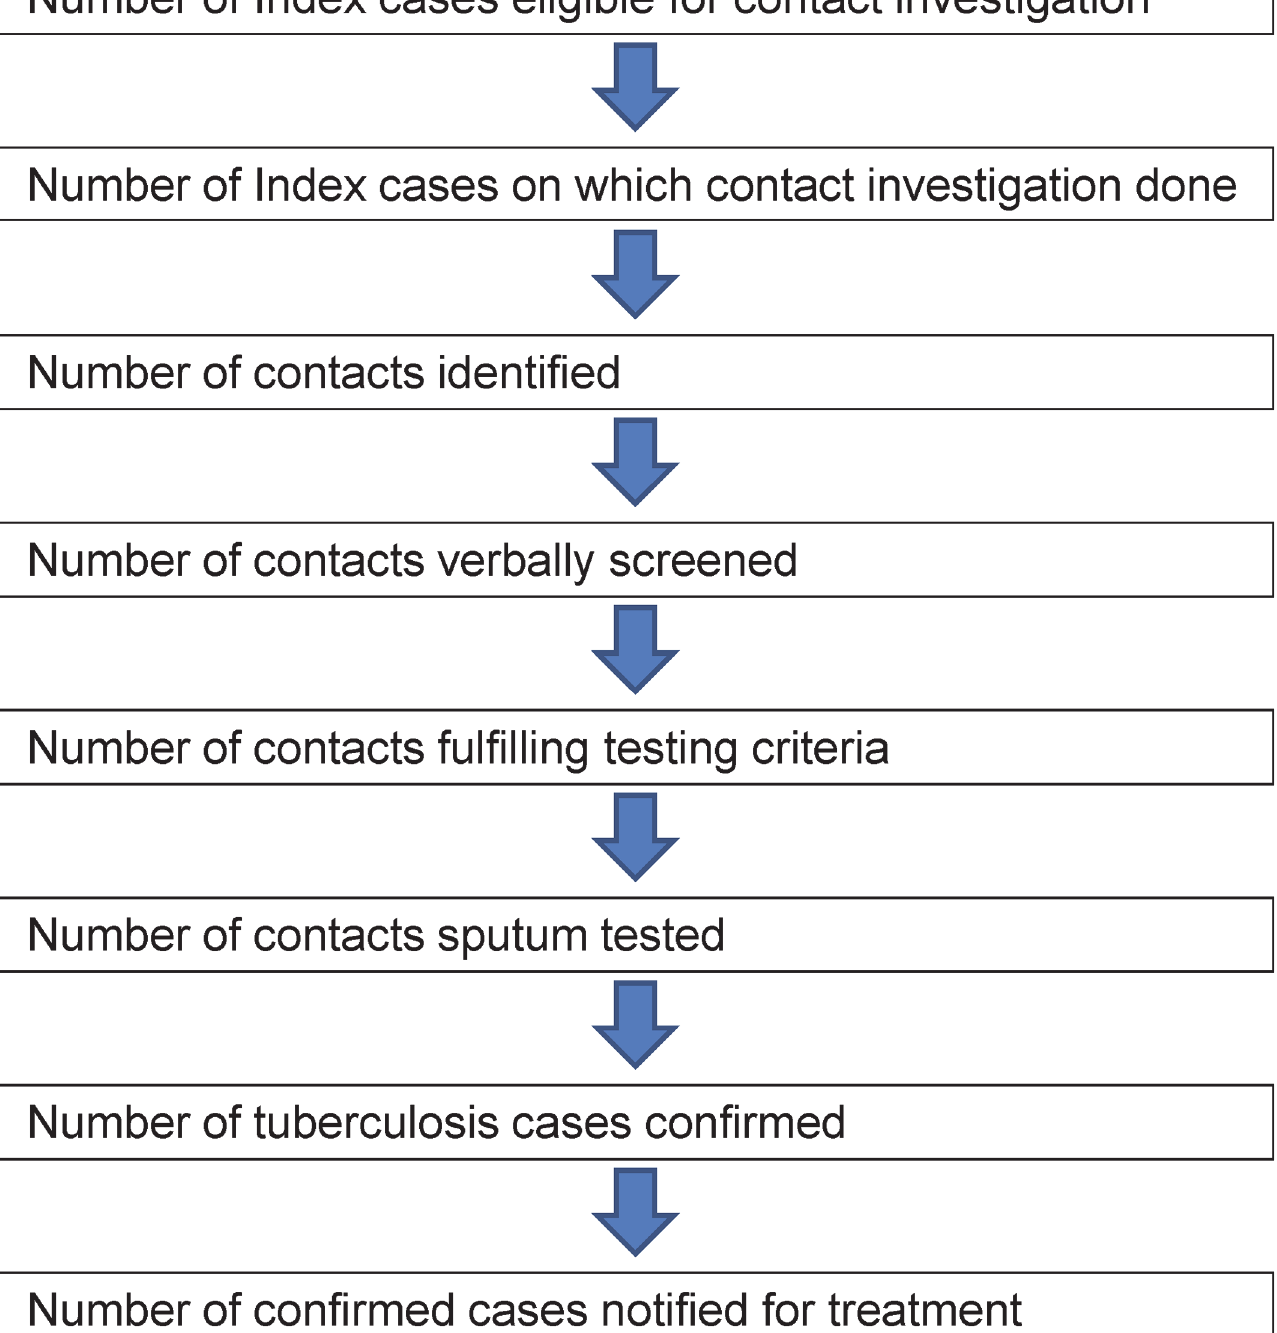
Fig 1. Process Indicators in Contact